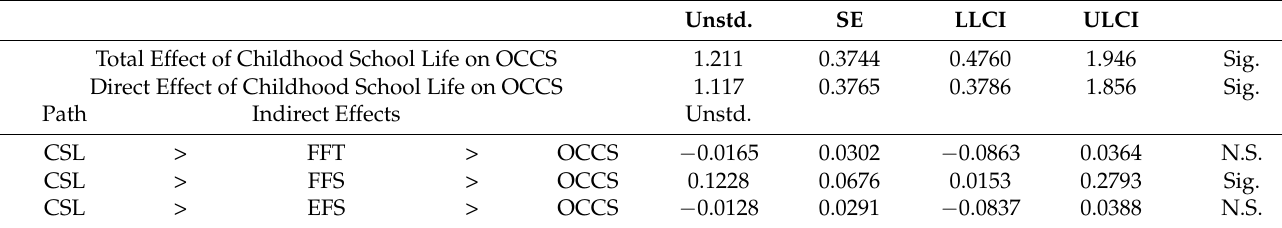
Table 4. Total, Direct, and Indirect Analysis on OCCS.